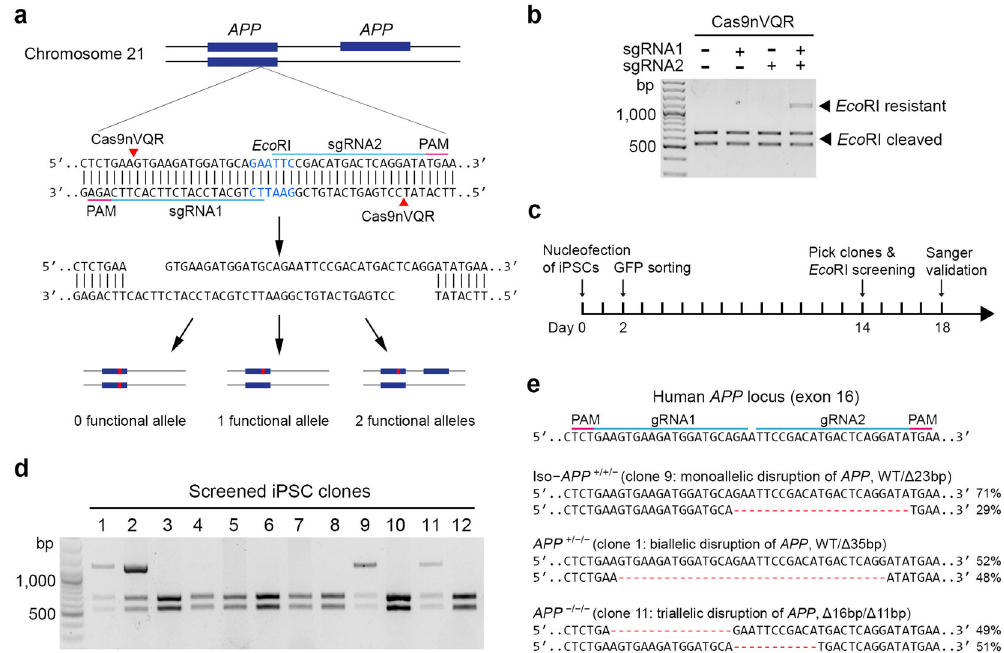
Fig. 1 Footprint-free gene editing of APP copy number in human induced pluripotent stem cells by paired Cas9 nickases. a Design of a scarless, antibiotic marker-free, gene-editing strategy using a newly generated Cas9 nickase variant, Cas9nVQR (D1135V/R1335Q/T1337R), with paired single- guide RNAs (i.e., sgRNA1 and sgRNA2) that target APP exon 16 in neurons with APP duplication. Red arrowheads indicate the nickase cleavage site, blue boxes indicate the exon, and the red line within the blue boxes indicates Cas9-induced insertion/deletion (indel) mutations. b Genome-editing ef fi ciency of Cas9nVQR with paired sgRNAs in HEK 293T cells. Cas9nVQR with or without corresponding sgRNAs was transfected into HEK 293T cells. The Eco RI- resistant band at 1.1 kb indicates successful editing. c Schematic diagram of genome editing in a human induced pluripotent stem cell (iPSC) line carrying duplication of the APP gene. d Screening of gene-edited iPSC clones by Eco RI digestion. e Speci fi c deletion mutations detected in gene-edited iPSC clones by Sanger sequencing and next-generation deep sequencing. The percentage of deep-sequencing reads for each iPSC clone indicates the number of APP copies remaining intact or removed. One isogenic iPSC clone (Iso) had approximately one-third of 23-bp deletion reads and two-thirds of wild-type sequence reads, indicating that one copy of APP had been inactivated; therefore, it was used for subsequent experiments. PAM protospacer-adjacent